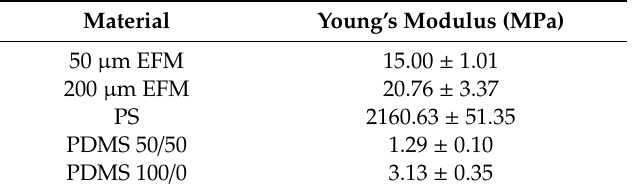
Data are displayed as mean ± standard